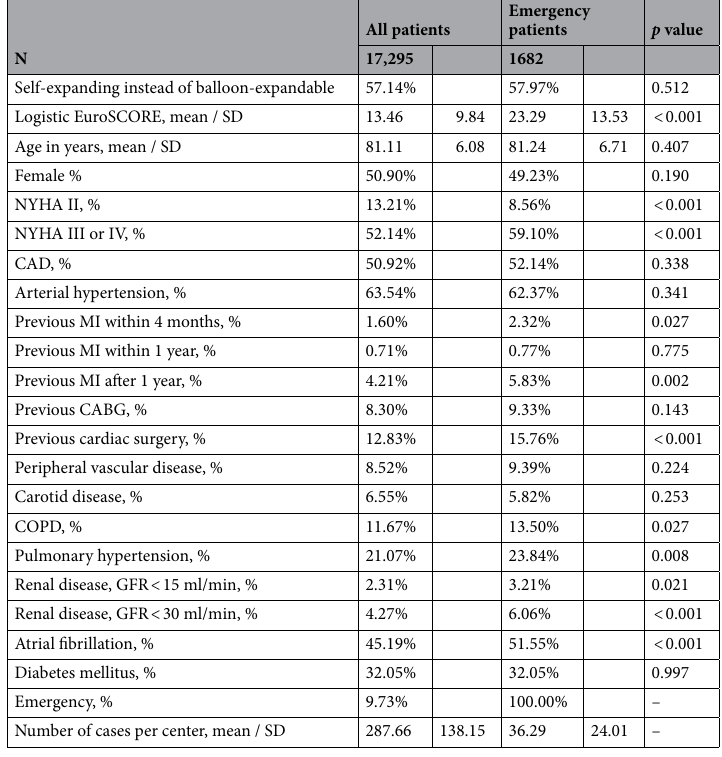
Table 1. Baseline characteristics of patients with balloon-expandable or self-expanding TAVI in Germany in 2018. CABG: coronary artery bypass graft; CAD: coronary artery disease; COPD: chronic obstructive pulmonary disease; EuroSCORE: European System for Cardiac Operative Risk Evaluation; GFR: glomerular filtration rate; MI: myocardial infarction; N: number of procedures; NYHA: New York Heart Association; SD: standard deviation. p-values based on chi-square test or t-test, as appropriate.